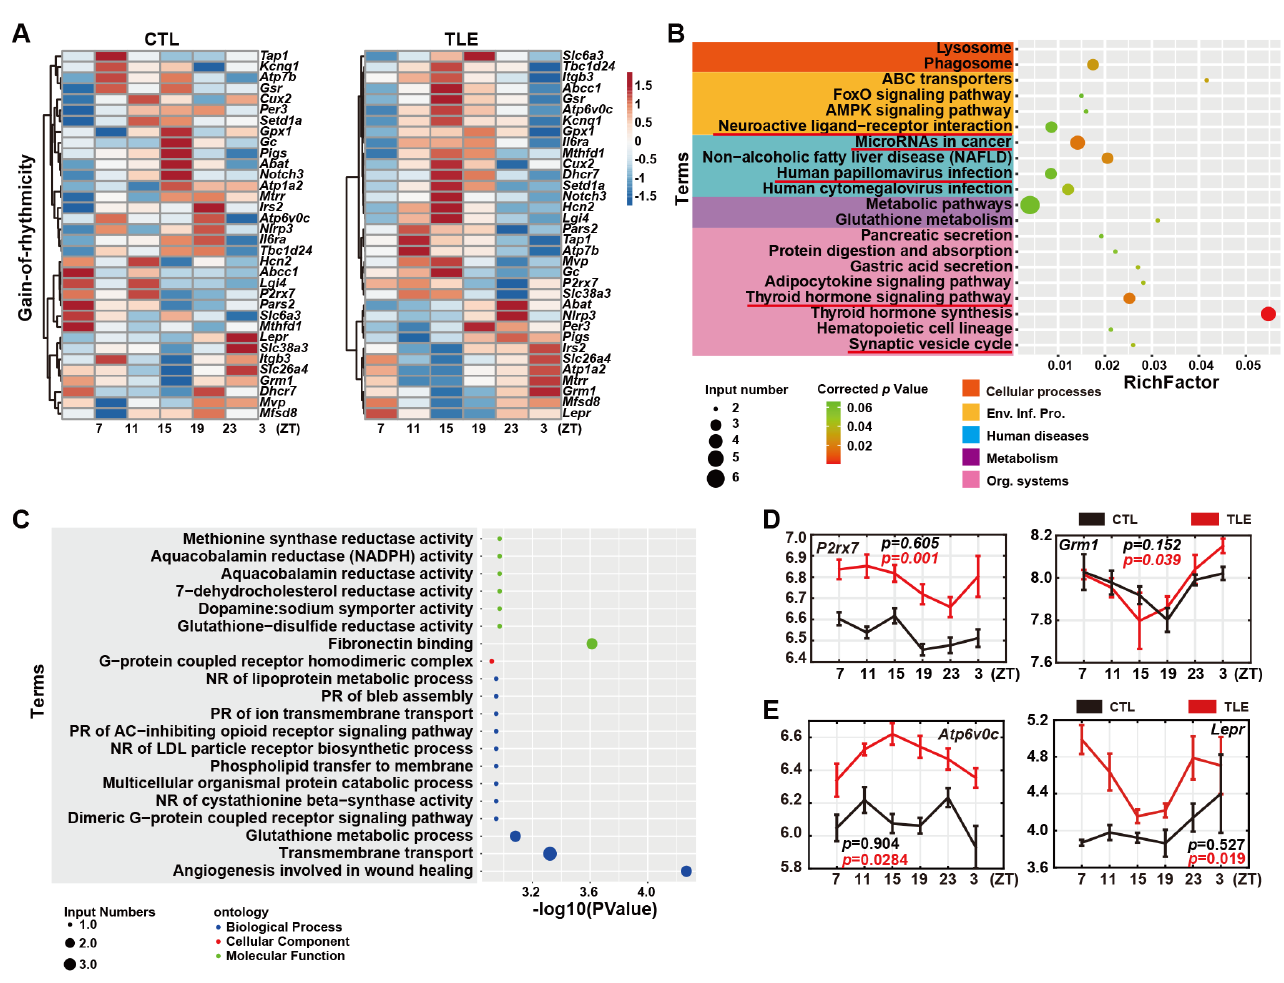
Figure 3. Analysis of 34 gain - of - rhythmicity genes. ( A ) Heatmaps of 34 gain - of - rhythmicity genes in CTL ( left ) and TLE ( right ) mice. ( B ) Top 20 KEGG enrichment pathways of gain - of - rhythmicity genes in TLE mice. The same pathways that also occur in KEGG analysis of loss - of - rhythmicity genes are underlined. ( C ) Top 20 GO enrichment terms of gain - of - rhythmicity genes. ( D ) Expression of two representative gain - of - rhythmicity genes P2rx7 (purinergic receptor P2X 7) and Grm1 (gluta- mate metabotropic receptor 1) involved in the neuroactive ligand - receptor interaction pathway. ( E ) Expression of two driver genes in the gain - of - rhythmicity group, including Atp6v0c (ATPase H + transporting V0 subunit c) and Lepr (leptin receptor). The black curve represents gene expression values from the CTL mice, and the red curve is for those in TLE mice.